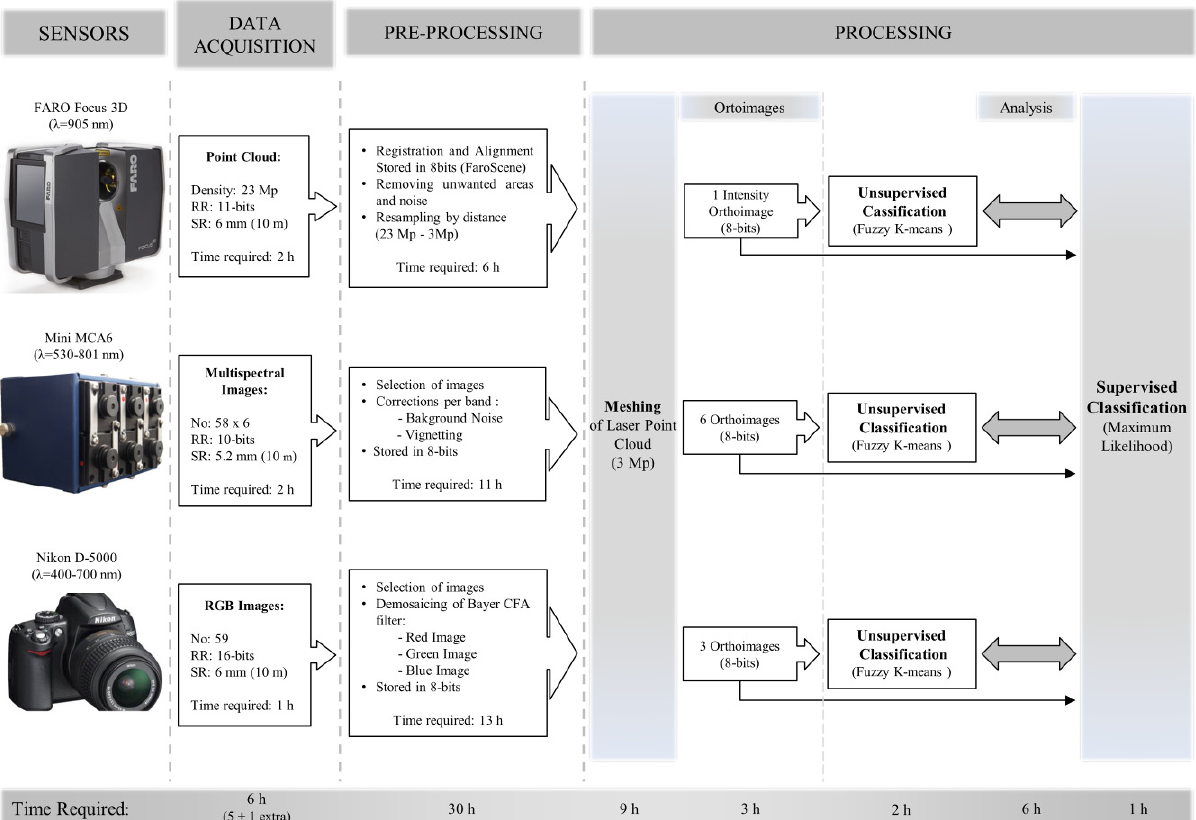
Figure 1. The workflow of the methodology presented. RR= Radiometric resolution, SR= Spatial resolution, Mp= Million